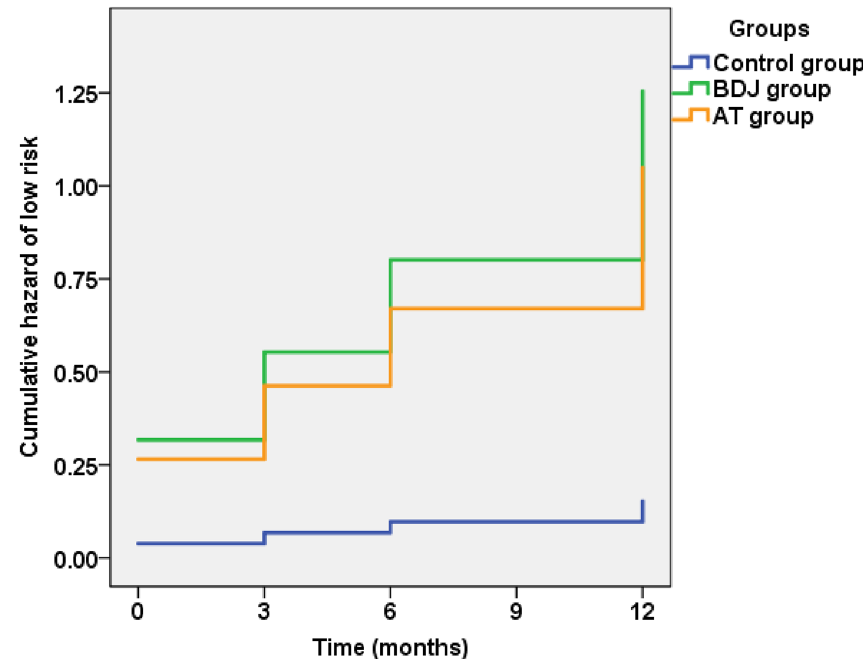
Figure 2. The change trend of 10-year ASCVD risk in the 3 groups.